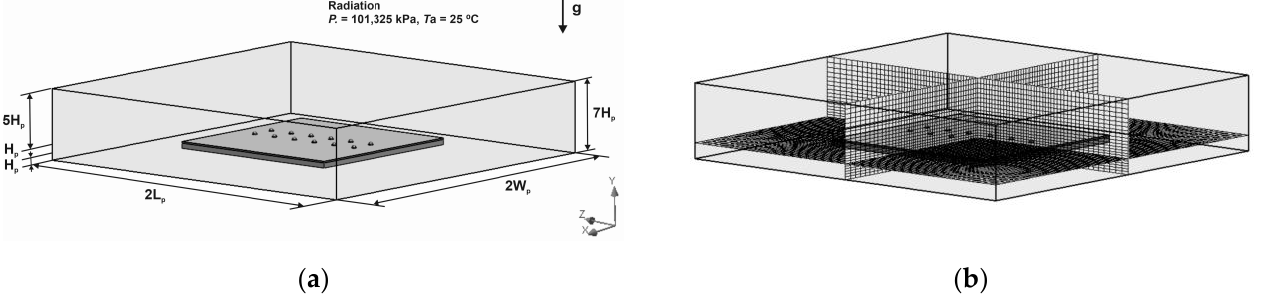
Figure 5. Simulation model of the LED panel: ( a ) computation domain with the assumed boundary conditions and ( b ) cross-section of the computation grid along the XYZ axis.